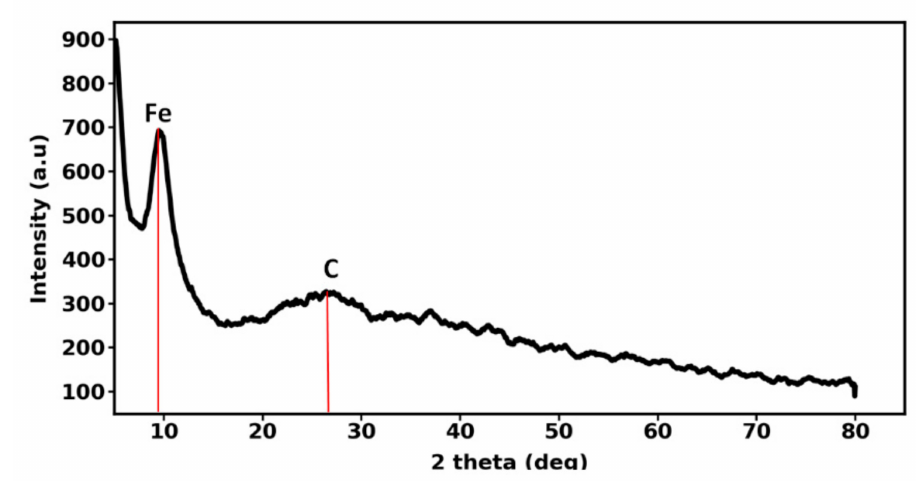
Figure 2. XRD pattern of iron-carbon nanohybrid.